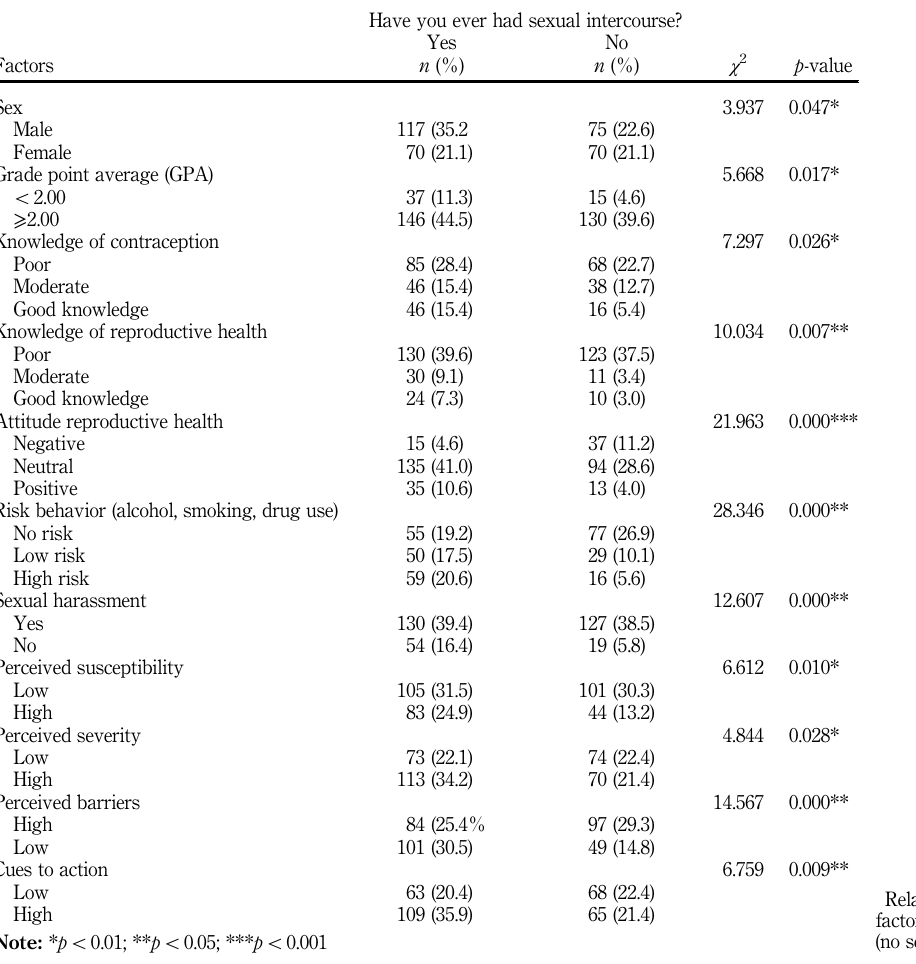
Table II. Relationship between factors and abstinence (no sexual